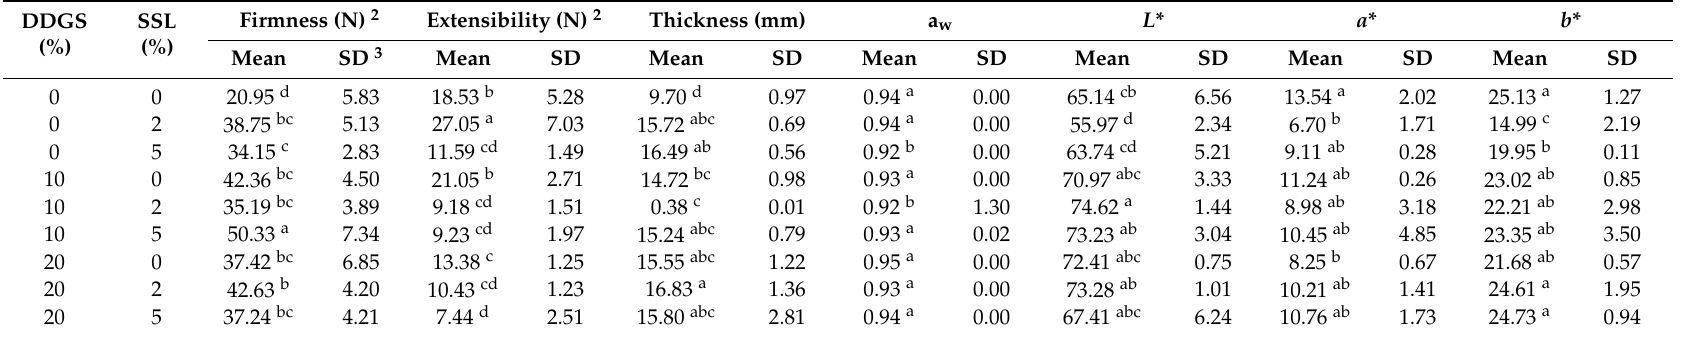
Table 5. Treatment effects on physical properties of baked breads 1